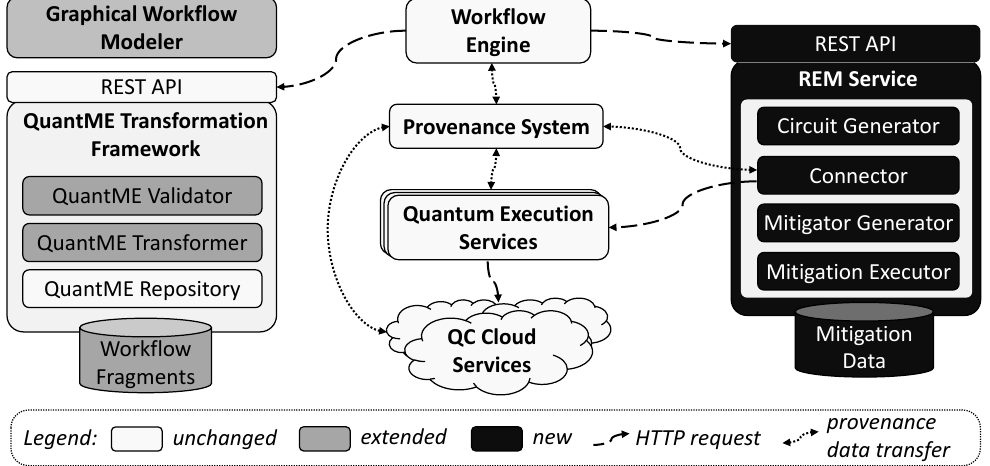
Figure 7. System architecture for automating REM configuration in quantum